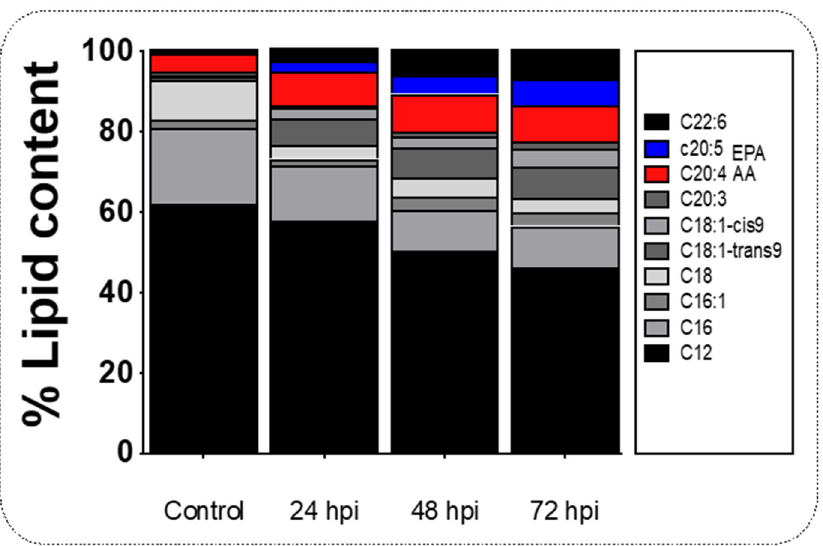
Figure 3. Lipid content profile in the liver tissue of salmon during infection. Composition of lipids in the liver of salmon infected at 24 to 72 hpi. Control sample corresponds to unchallenged fish. Data represent the mean ± SEM. Two-way ANOVA; p < 0.05 was considered statistically significant. Long-chain fatty acid biosynthesis depends on the complementary roles of fatty acyl elongases (Elovls) and desaturases (fads). To investigate whether the accumulation of AA and EPA in the liver was accompanied by changes in both lipid elongation and desaturation cycles, we measured mRNA levels of elovl5 and elovl2 and d5fad and d6fad , and two recognized elongases and desaturases codifying genes, respectively. As shown in Figure 4A, elovl5 liver levels decreased significantly from 57 to three copy numbers after IPNV infection compared to non-infected fish (Figure 4A; p < 0.01). Similarly, d5fad and d6fad transcripts significantly decreased at all post-infection stages (Figure 4C,D; p < 0.001). In contrast, elovl2 was upregulated in infected fish livers at 24 and 48 hpi (Figure 4B; p < 0.05).